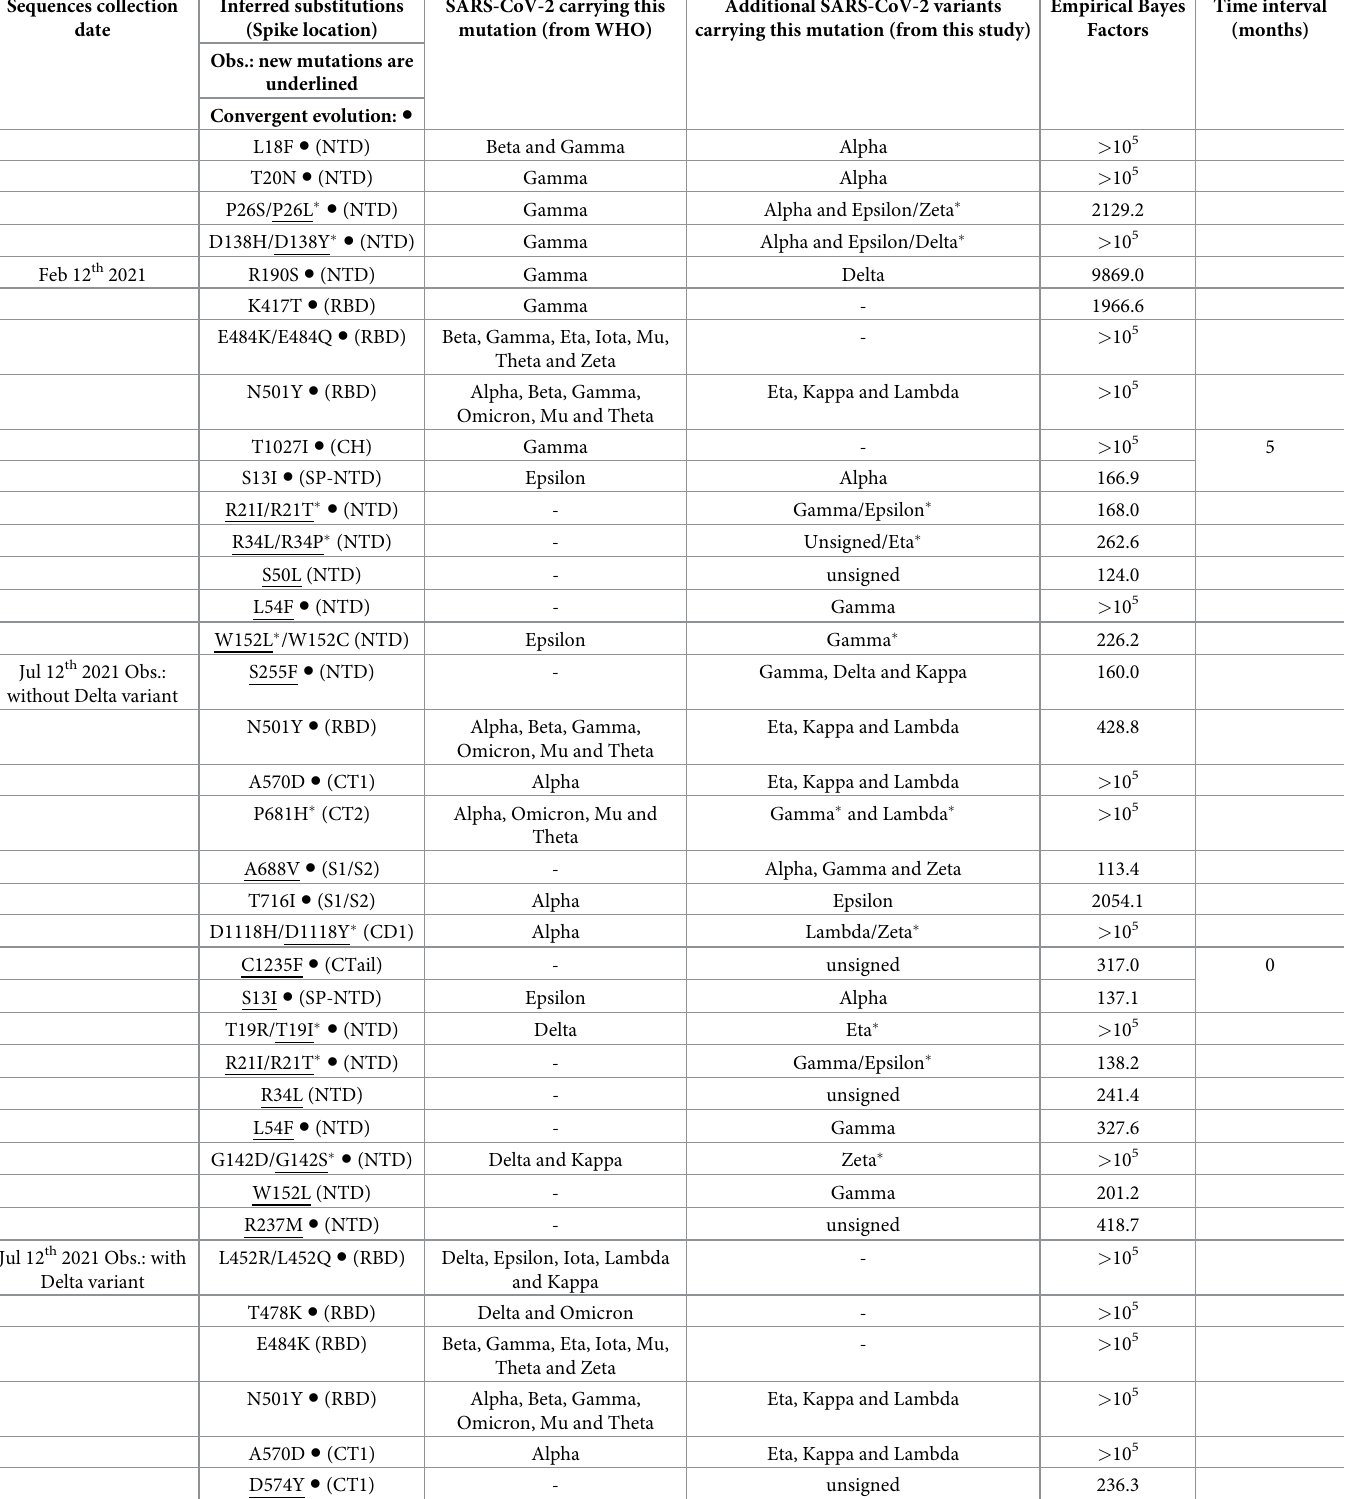
Table 1. Mutational landscape of SARS-CoV-2 Spike protein VOC and VOI based on the WHO label. Sequences collection